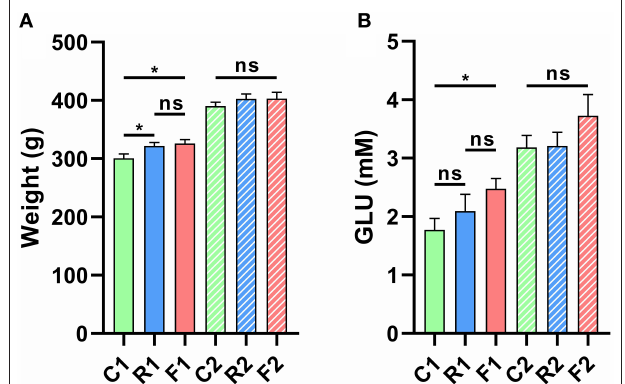
FIGURE 2 | Changes in body weight and glucose (GLU) levels of rats fed different diets and at different experimental stages. (A) The body weights of rats were significantly increased in R1 vs. C1 and F1 vs. C1 at stage 1, but no significant differences were observed at stage 2. (B) Glucose levels were significantly increased in F1 vs. C1 at stage 1, but no significant differences were observed at stage 2. * p < 0.05; ns, not significant. n = 9–10 (R1 have 9 rats, C1, F1, C2, R2, and F2 have 10 rats). “n” means the number of samples/rats per group.